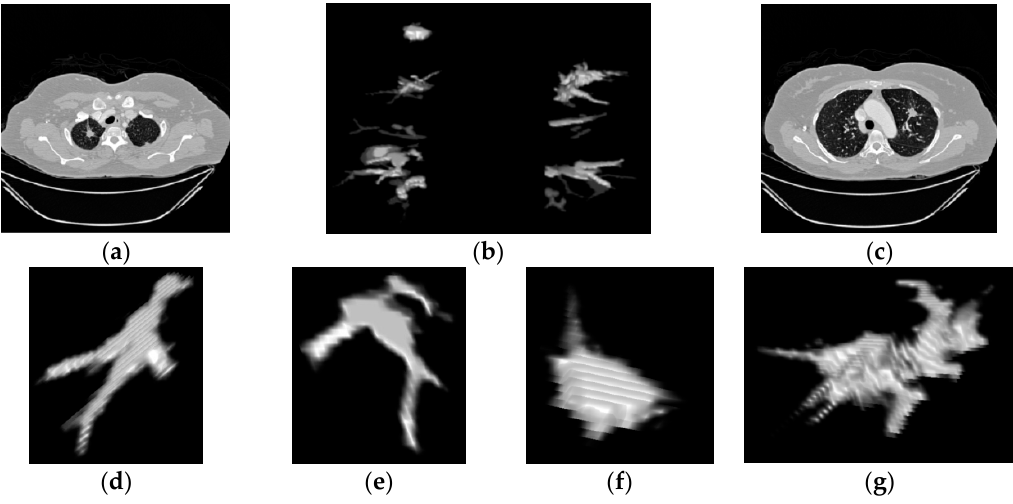
Figure 5. Precise Lung nodules detection ( a ) CT image containing the first nodule; ( b ) Lung 3D reconstruction; ( c ) CT image containing the second nodule; ( d – g ) all possible candidates before classification; ( d , e ) Non-nodules; ( f , g ) lung nodules determine after